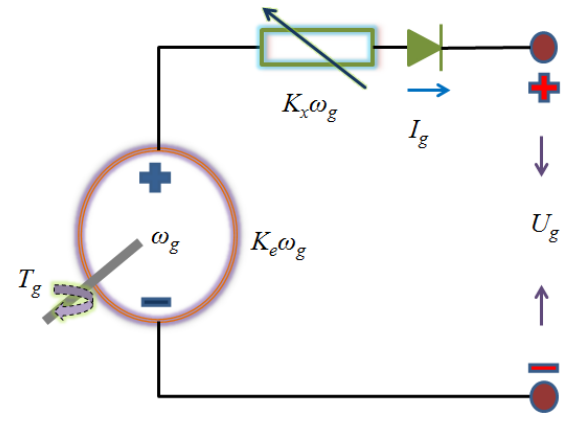
Figure 2. Equivalent circuit of the engine-generator set.